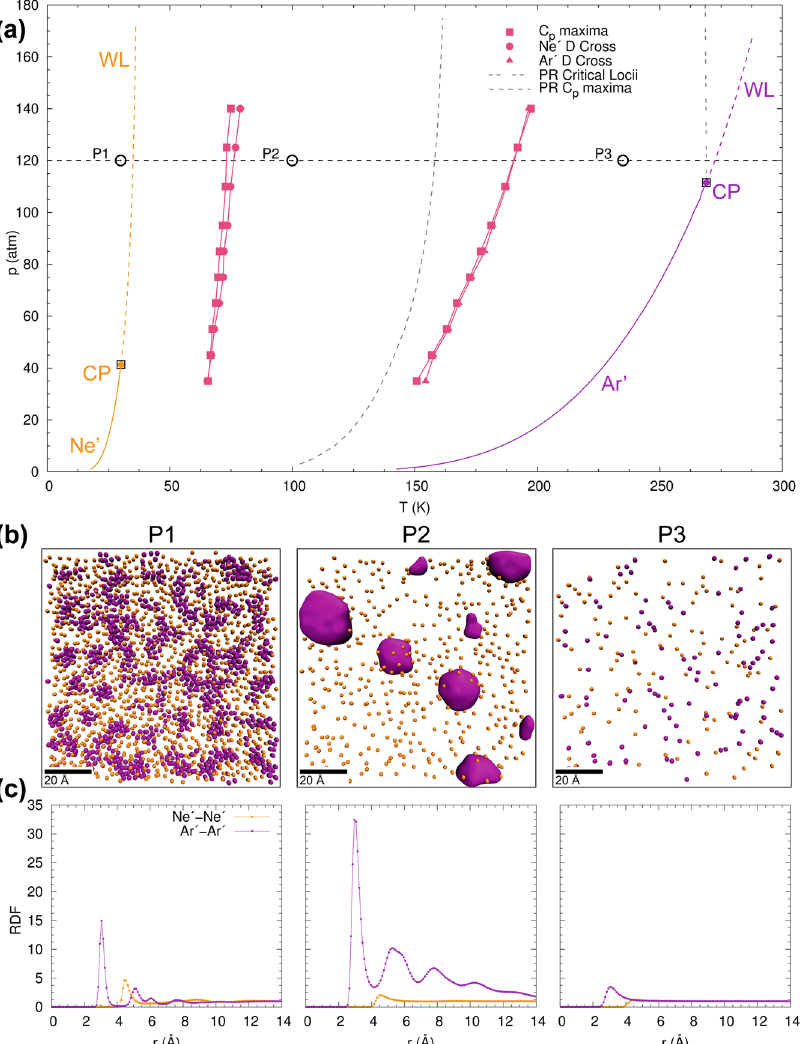
Figure 6. Supercritical state space and molecular structure of equimolar Ne ′ /Ar ′ mixture with strong self- interaction, showing ( a ) projected p - T state plane with locations of the maxima of C p , α p , κ T and diffusion coefficient crossovers as obtained from isobaric MD-simulations; ( b ) MD-snapshots of molecular structure and ( c ) radial distribution function at a supercritical pressure of 120 atm and three different temperatures (30 K, 100 K, and 235 K; from left to